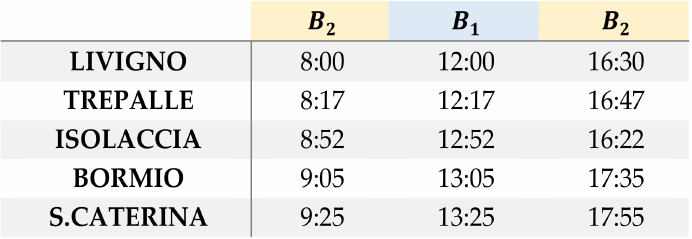
Figure 15. Low season